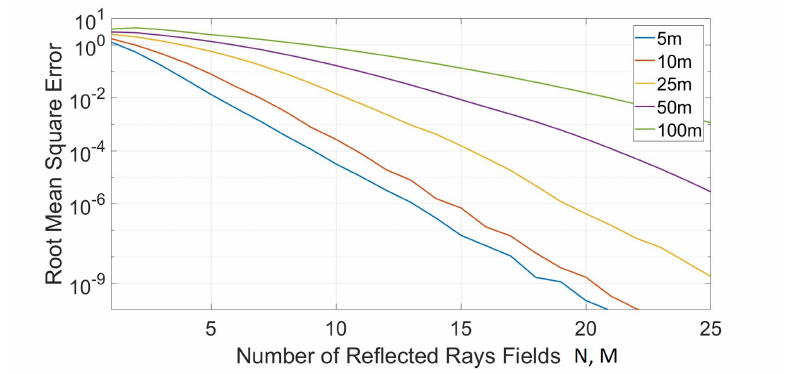
Figure 5. Root mean squared error at 28 GHz inside the tunnel.